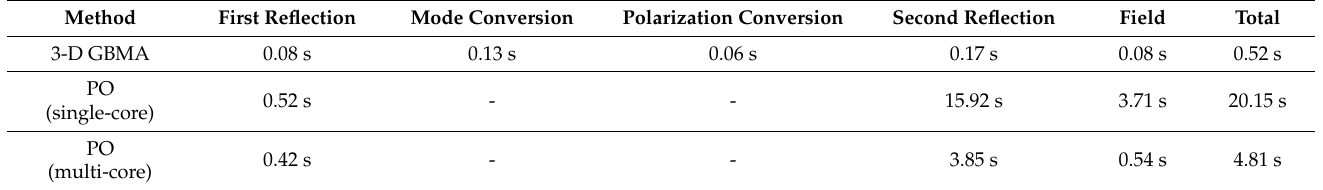
Figure 11. The near field phase results of the fabricated quasi-optical system with θ r = π /2: ( a ) the simulated results; ( b ) the measured results. Table 2. Execution time of 3-D GBMA and PO